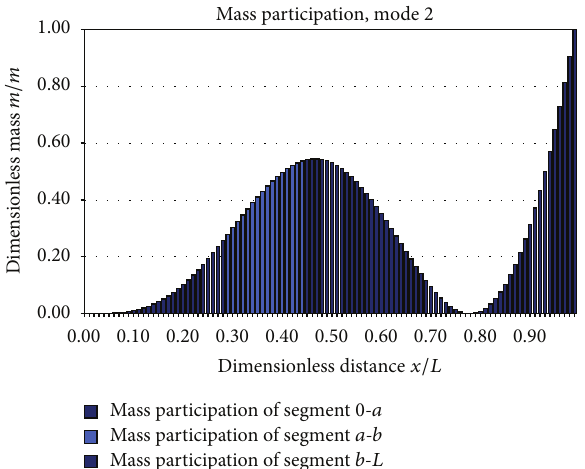
Figure 5: The mass participation in the total kinetic energy of the uniformly distributed loads for 100 slices placed along the